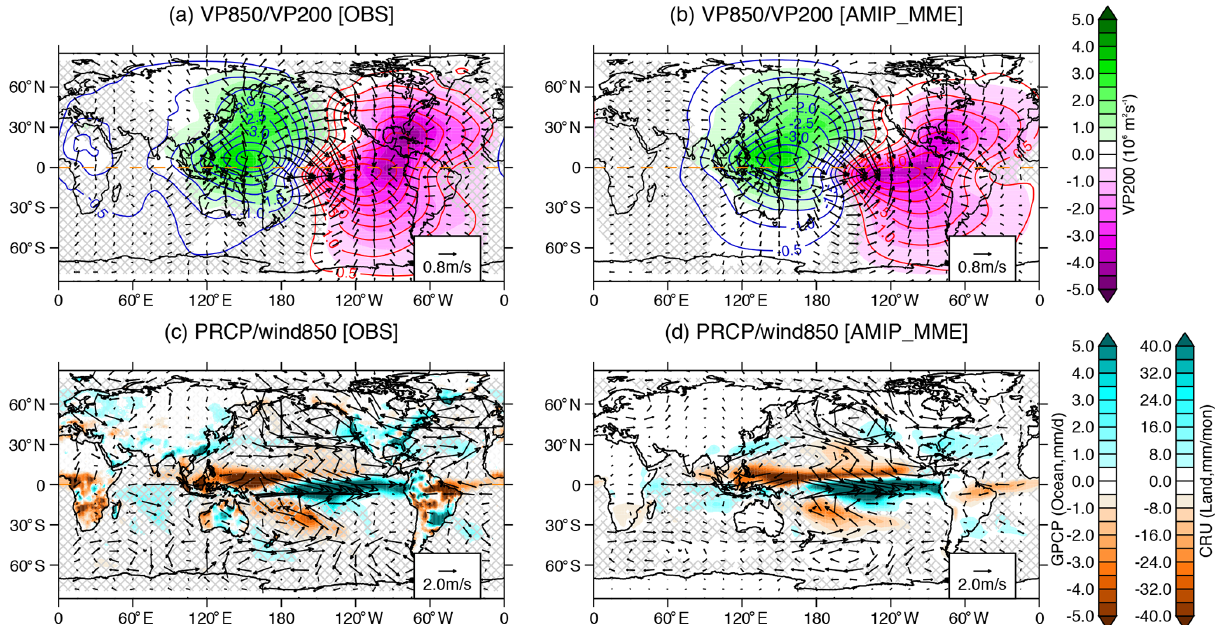
Figure 4. Global pattern of phase-synchronized spatial shifts of HC and WC. Composite anomalies during PSYN months (i.e., the absolute tendency of phase difference is less than 0.3) with February–March–April (FMA[1]) extreme El Niño (FMA[1] Niño3 > 1 . 5SD), obtained from the observations (a, c) and the AMIP MME (b, d) : (a, b) 850hPa velocity potential (VP850; contours) and 200hPa velocity potential (VP200; shading) anomaly; (c, d) precipitation (GPCP for ocean and CRU for land; shading) and 850hPa wind (vector) anomaly. The hatching shows the area where the difference is statistically insignificant at the 99% confidence